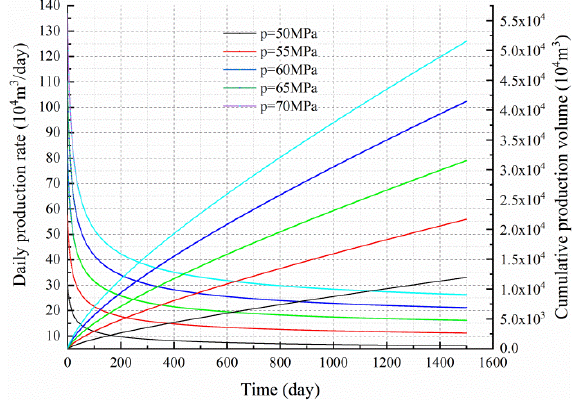
Figure 15. The e ff ect of di ff erent formation pressures on productivity. Figure 15. The effect of different formation pressures on productivity.